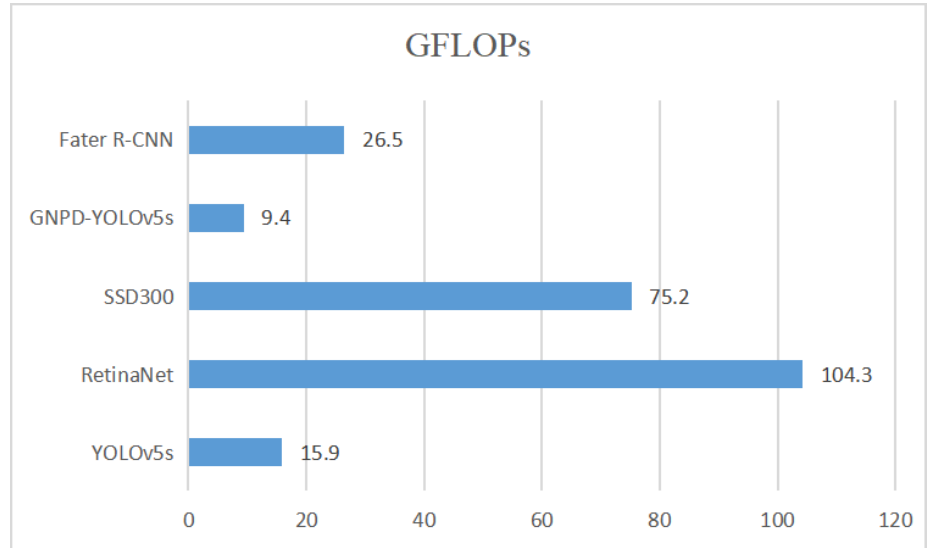
Figure 11. Comparison of GFLOPS amount between GNPD-YOLOv5s chili detection model and other mainstream models. Table 2. Performance comparison of mainstream recognition algorithm models.